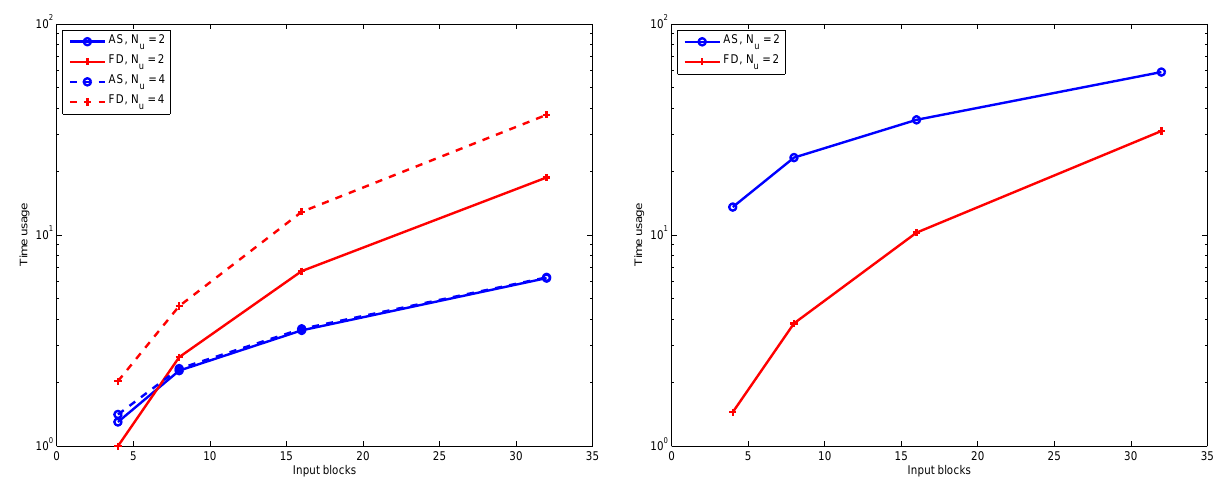
Figure 9: Relative time usage for different number of inputs and input blocks.